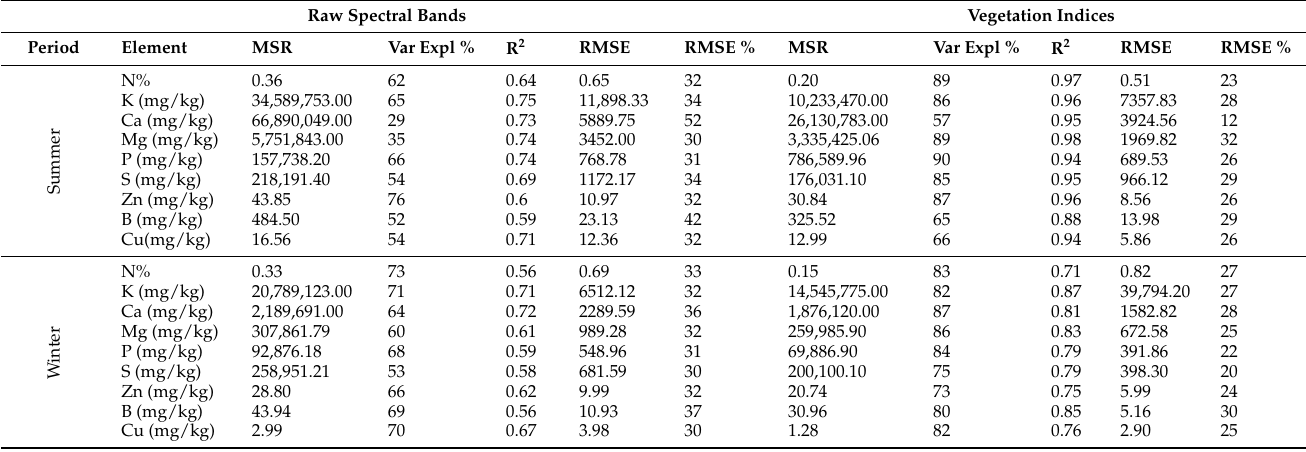
Table 4. Dry and wet season nutrient concentration estimation accuracies for crops. Raw Spectral Bands